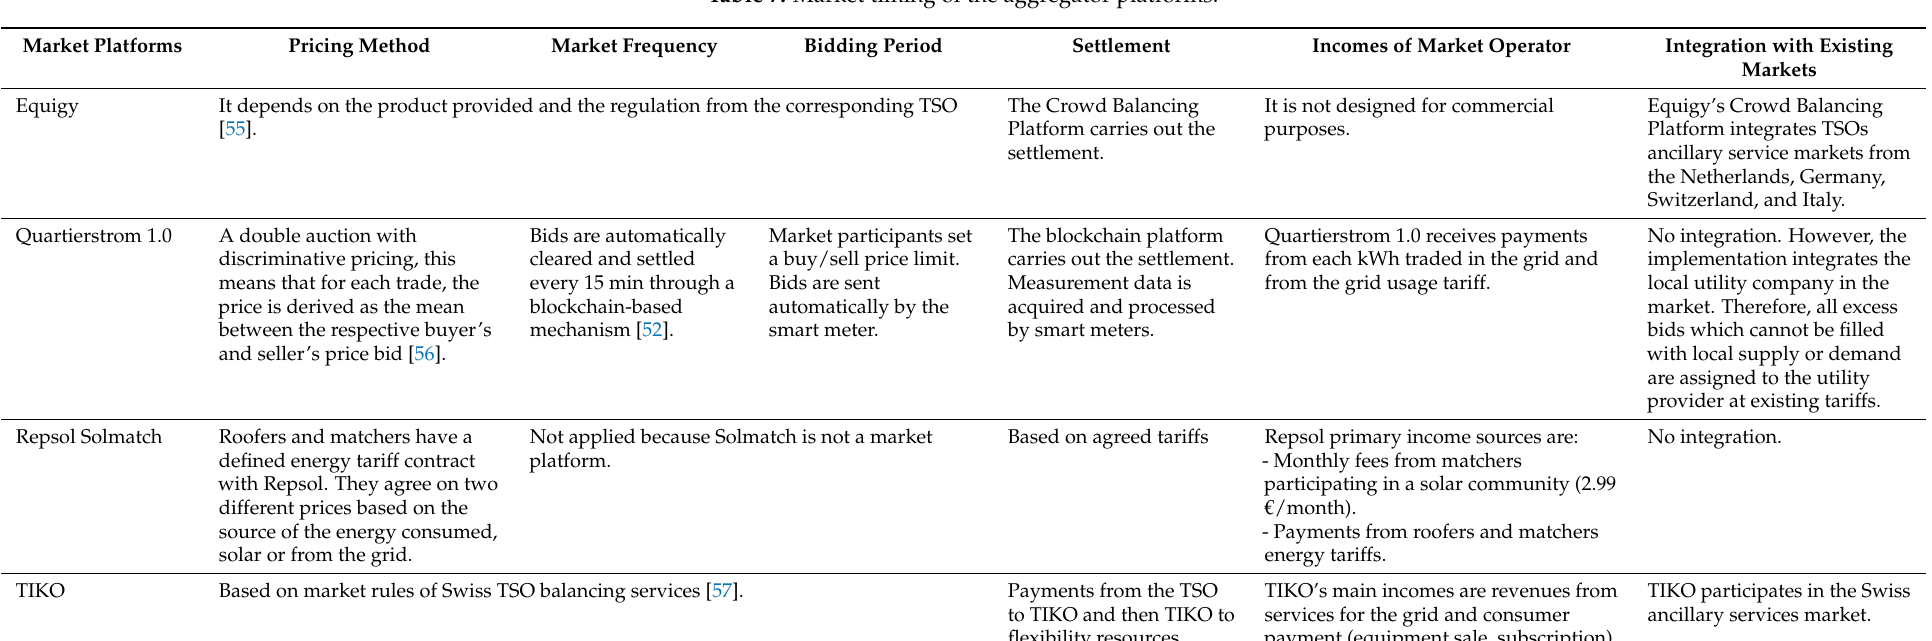
Table 7. Market timing of the aggregator